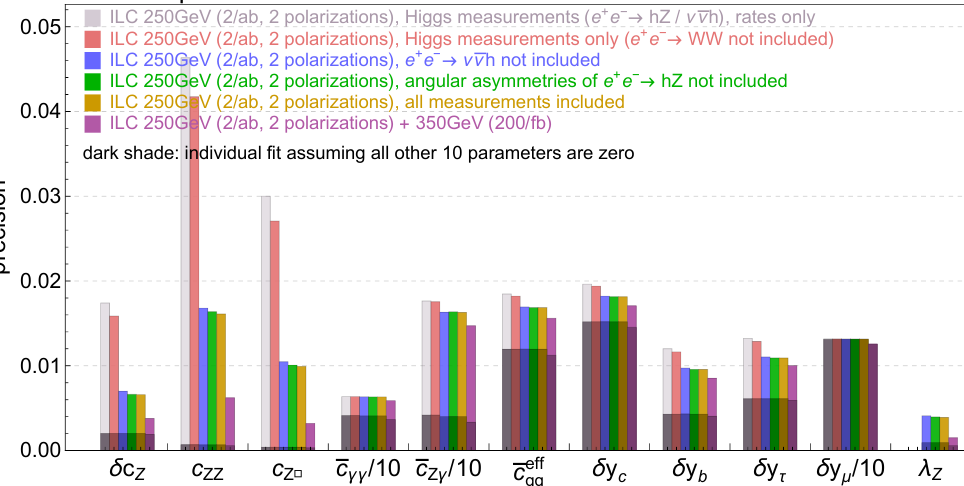
+ ) = ( 0 : 8 ; +0 : 3) and (+0 : 8 ; 0 : 3), (cid:0) ; e (cid:0) (cid:0)